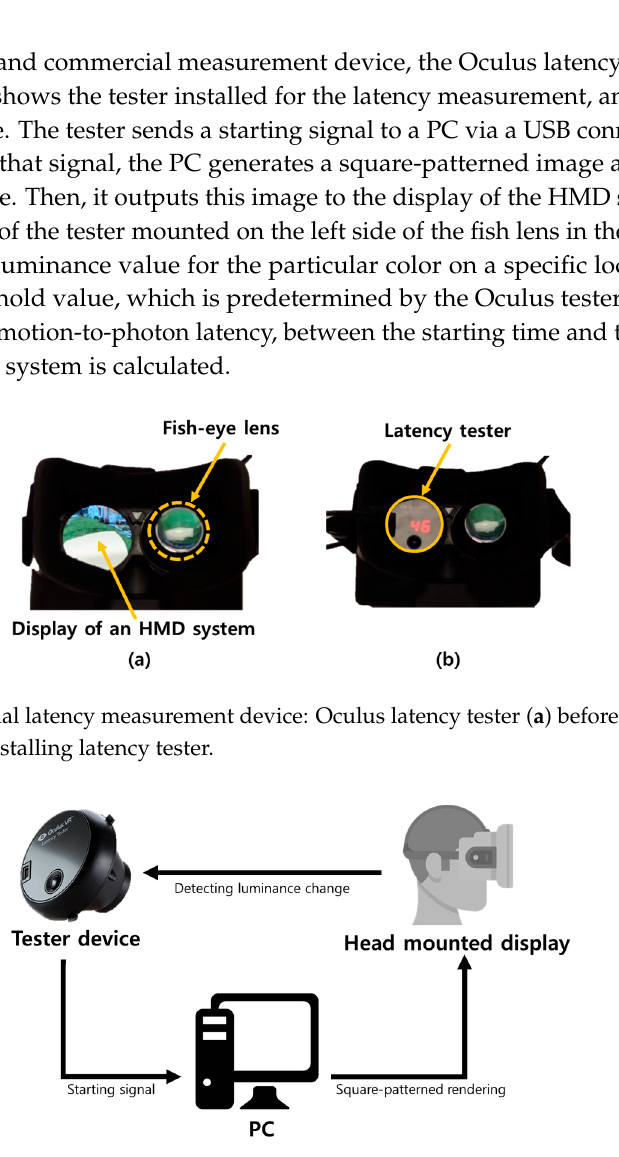
Figure 3. Measurement procedure of the Oculus latency tester.